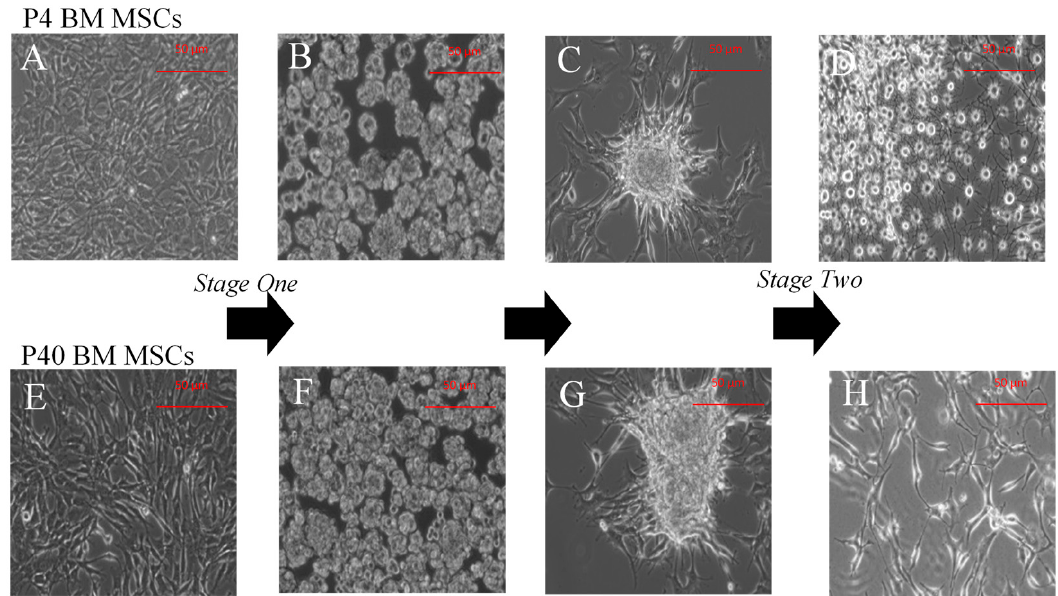
Figure 3. Morphological changes throughout the IDI. P4 ( A ) and P40 ( E ) MSCs before induction. Following exposure to bFGF, EGF, and B-27 (without Vitamin A), both P4 ( B ) and P40 ( F ) MSCs formed free-floating spheres. Cells adhered to poly- L -ornithine-coated coverslips and single cells grew outward from the attached sphere; (( C ) P4 NSCs) (( G ) P40 NSCs). Following exposure to SHH, FGF-8, bFGF, and BDNF, both P4 and P40 MSC displayed changes in morphology toward a neuronal phenotype (( D ) P4 MSCs post-induction, ( H ) P40 MSCs